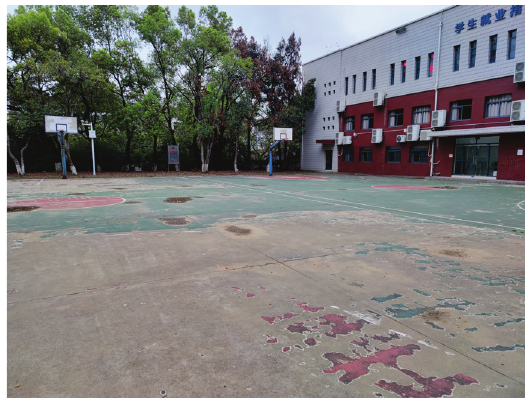
Figure 5 . Test environment of the UWB positioning system.